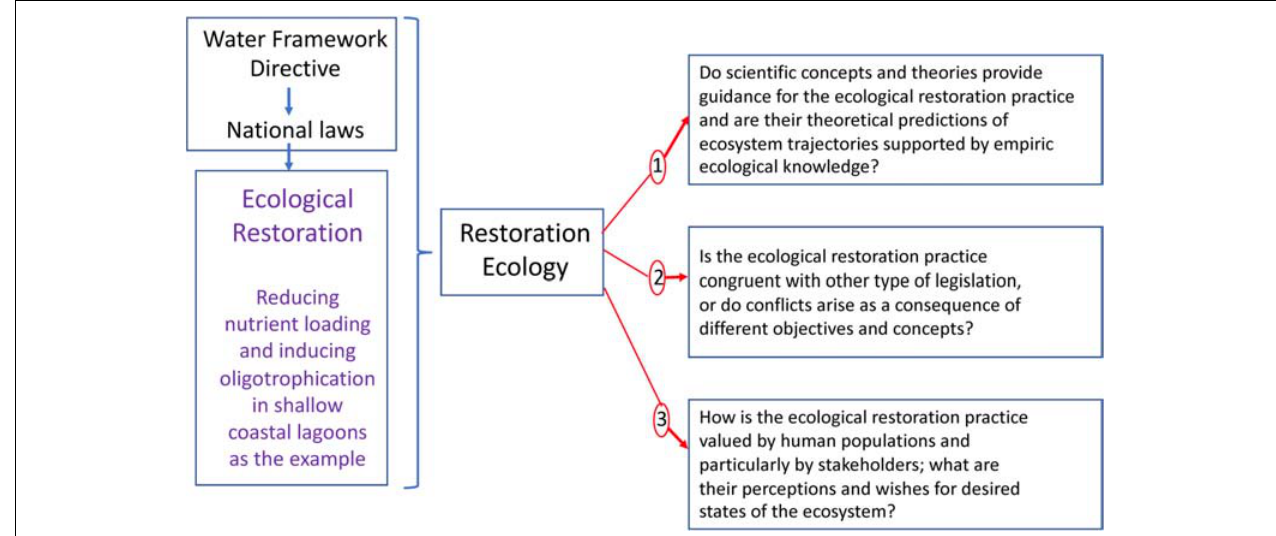
FIGURE 1 | The Water Framework Directive (2000/60/EC) through its transposition into national laws [in France: Loi n ◦ 2006–1772 du 30 décembre 2006 sur l’eau et les milieux aquatiques (French law)] has resulted in South France in ecological restoration practice to improve the ecological status of coastal lagoons. A particular focus has been on reducing nutrient loading to combat eutrophication and thus induce oligotrophication of coastal lagoons. In this article this practice has been analyzed according the theoretical framework of restoration ecology and three main questions have been formulated for this